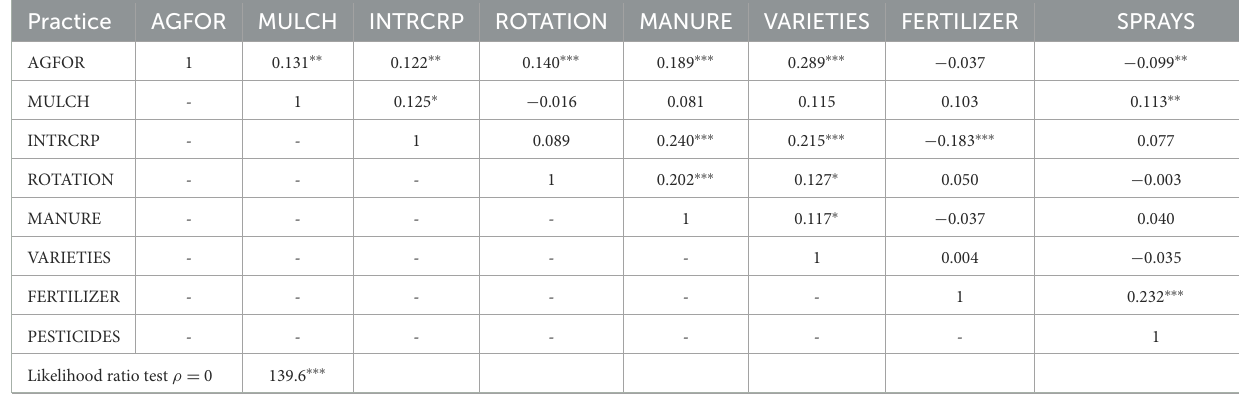
TABLE 3 Correlation matrix of the multivariate probit model for joint decisions on practice adoption in the four Mali sites. Practice AGFOR MULCH INTRCRP ROTATION